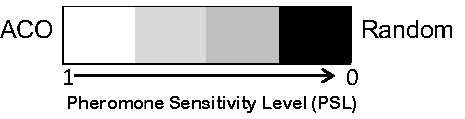
Figure 1. Symbolic illustration of the sensitive ant model showing the ants’ probability variation within the unit interval from the ACO probability when PSL = 1 to a random walk probability when PSL =